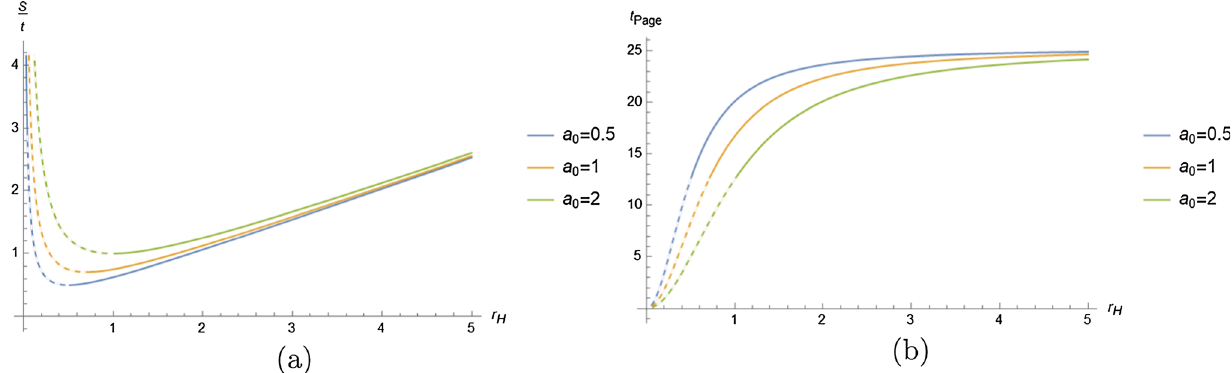
Fig. 4 The increased rate of the entanglement entropy and the Page time as a function for the radius at a 0 = 0 . 5 , 1 , 2. The dotted line represents the unstable small black hole